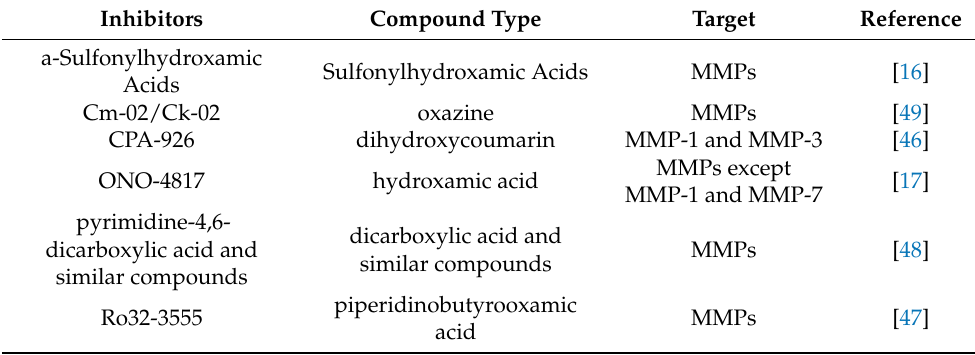
Table 1. Small molecule inhibitors targeting the MMP gene family for OA.